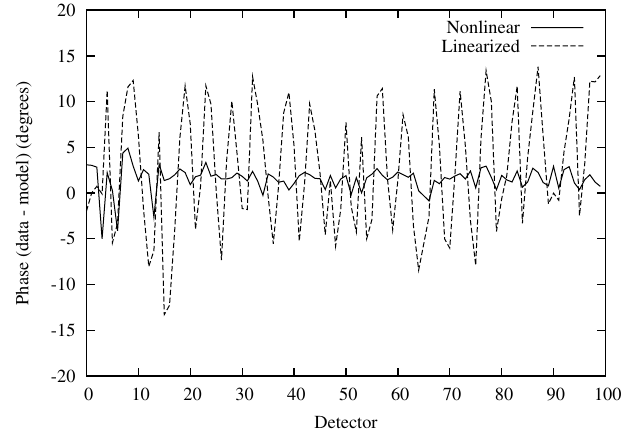
FIG. 7. Difference in horizontal betatron phase advance be- tween data and model with large closed orbit distortion after using a phase correction algorithm based on the linear (dashed) and nonlinear (solid) BPM